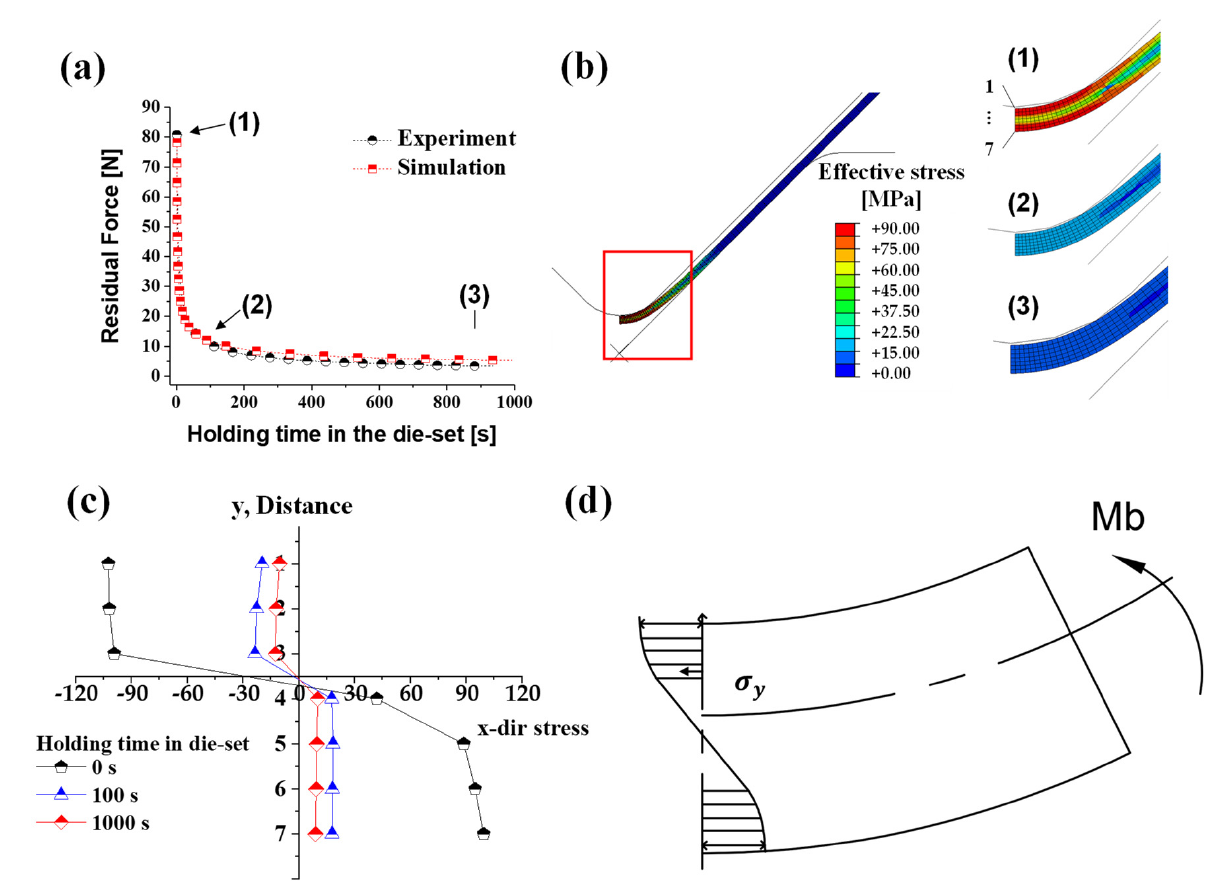
Figure 21. ( a ) The comparison between experiment and simulation results of a residual force; ( b ) visualization of ( c ) stress distribution according to the holding time in the die set; ( d ) the schematic of stress distribution.